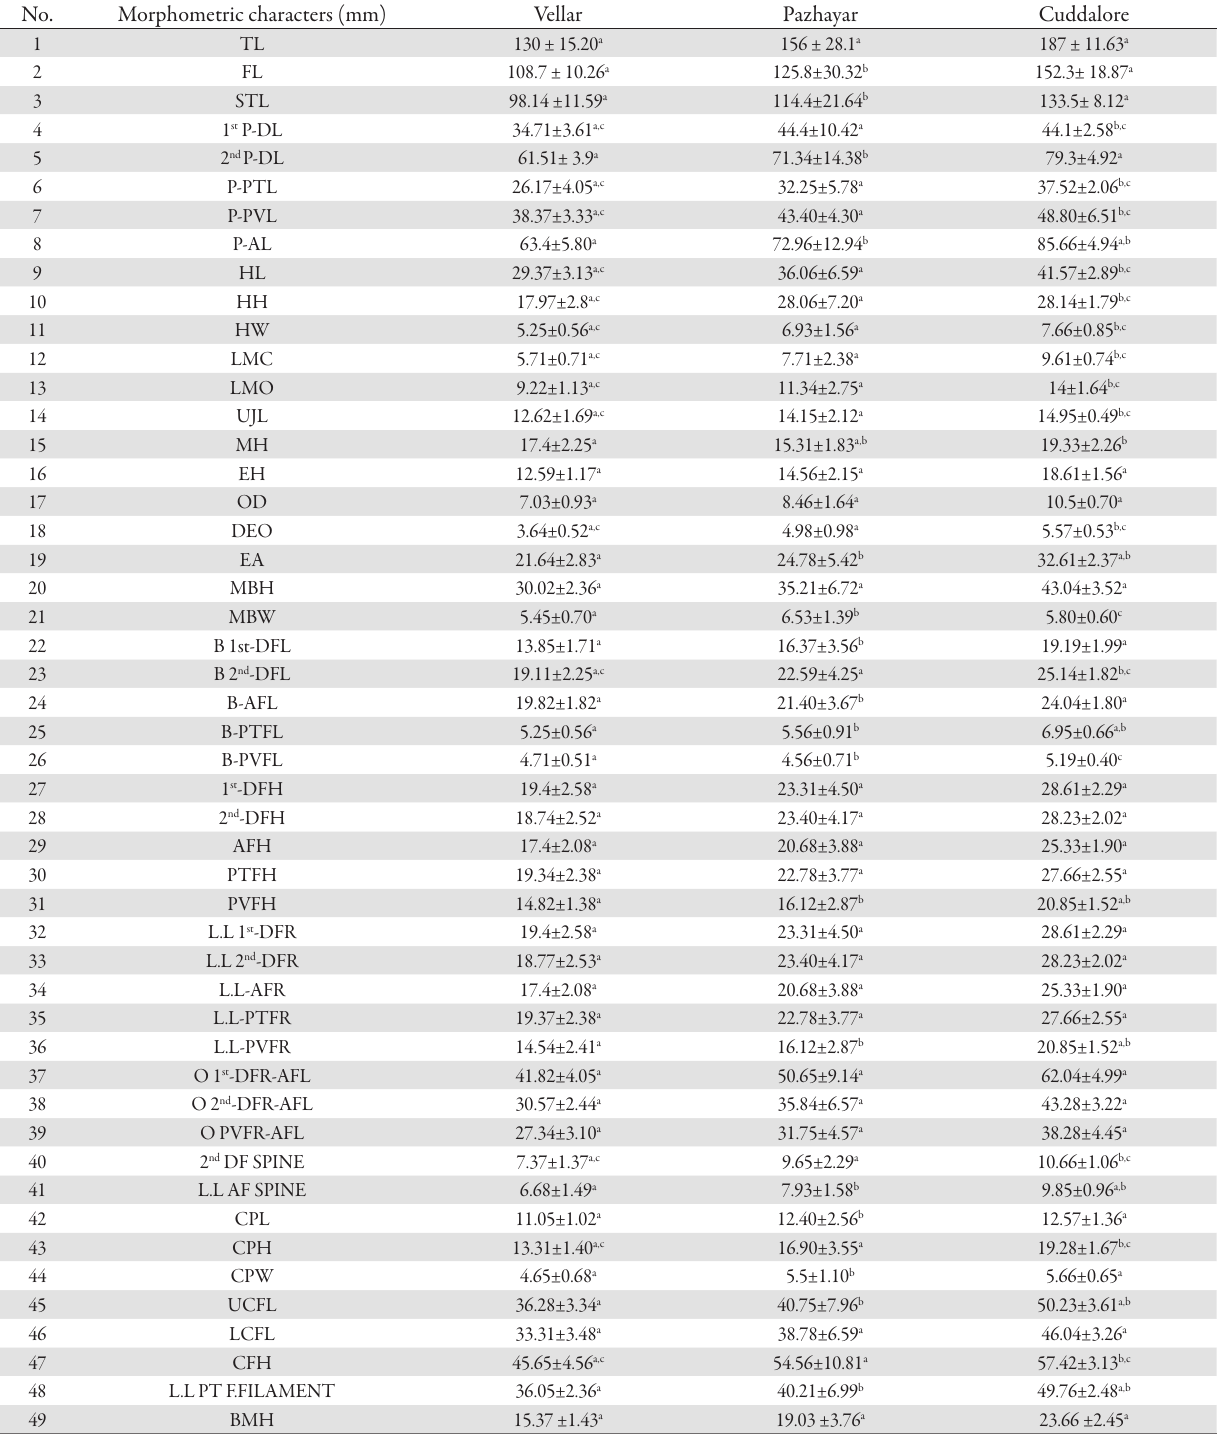
Tab. 1. Morphometric characters observed in three populations of P. plebeius